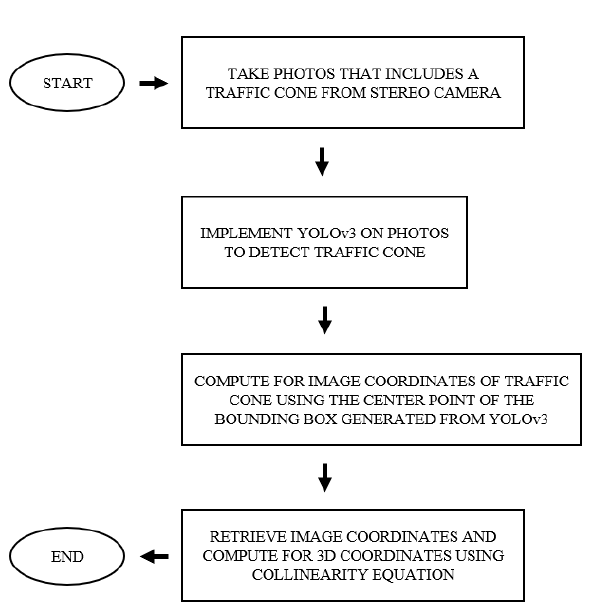
Figure 4. General Methodology of the Research